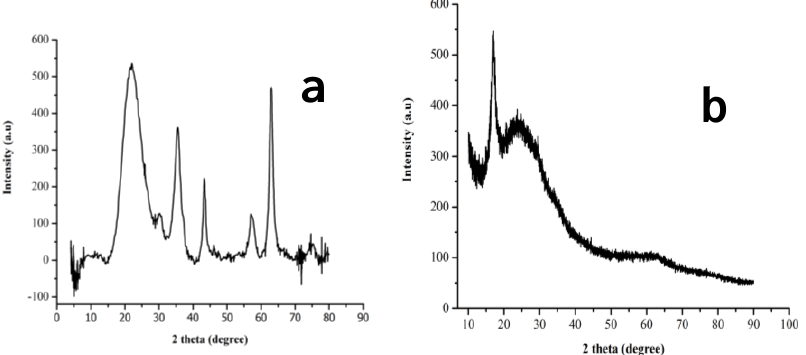
Figure 1. XRD patterns of ( a ) Fe 2 O 3 -SiO 2 and ( b ) Fe 2 O 3 -SiO 2 -PAN.